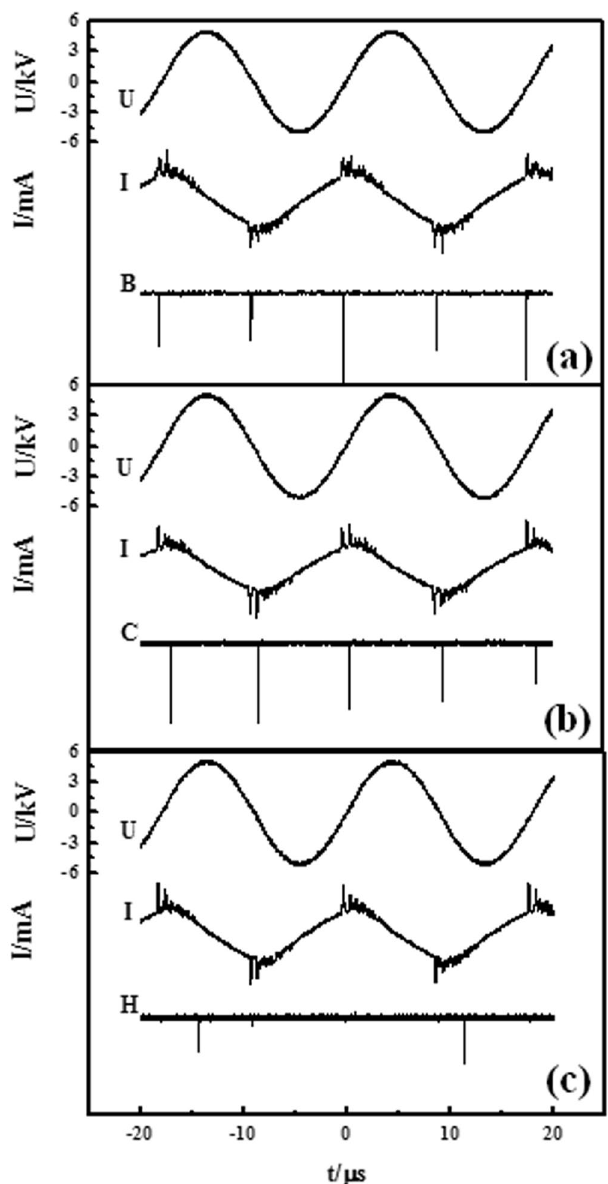
Figure 3. Time correlation measurement of the white-eye square grid state. B stands for the big spots in the center of the halos, C stands for the central spots, H stands for the halos. ( a ) Time correlation measurement of big spots. ( b ) Time correlation measurement of central spots. ( c ) Time correlation measurement of halos. U stands for voltage curve, I stands for current